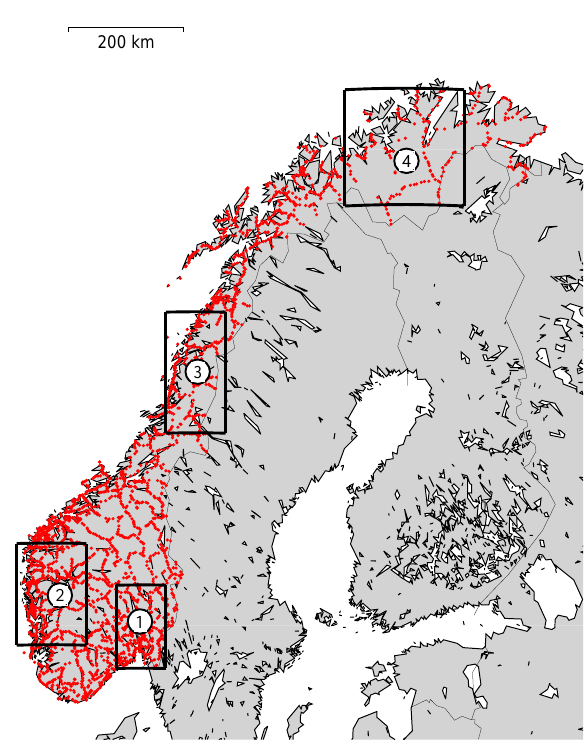
Figure 1: Mainland Norway is shown, together with the locations of the 3,297 normal heights (red dots) that realize the Norwegian height system NN2000. Statistical properties for the four marked locations are given in Table 1. Results from four sample regions containing these locations are given in Table